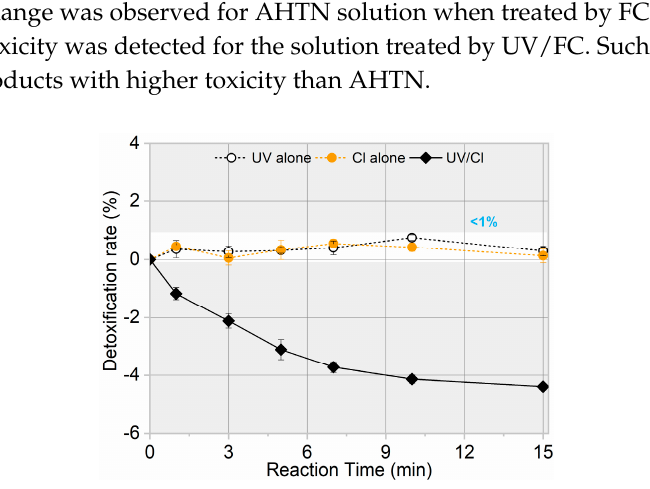
Figure 5. Toxicity evolution for AHTN degradation by UV, FC, and UV/FC ([AHTN] 0 = 1.0 mg · L − 1 ; pH = 7.0; 25 ± 1 ◦ C; and [FC] 0 = 3.28 mg · L − 1 ).